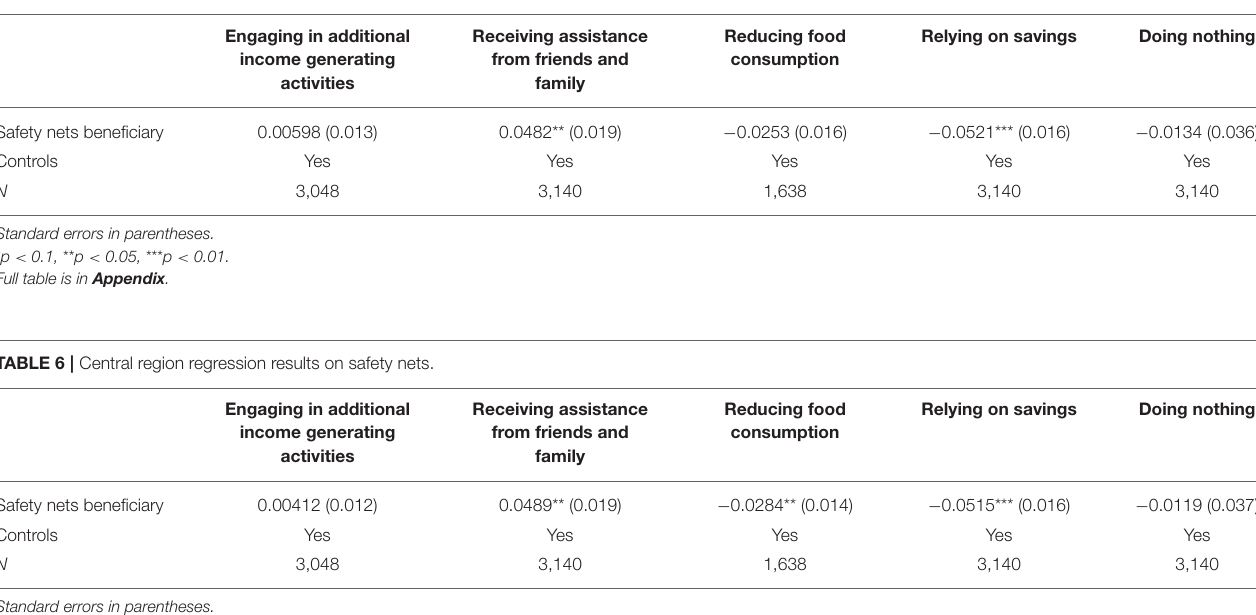
TABLE 5 | Northern region regression results on safety nets.